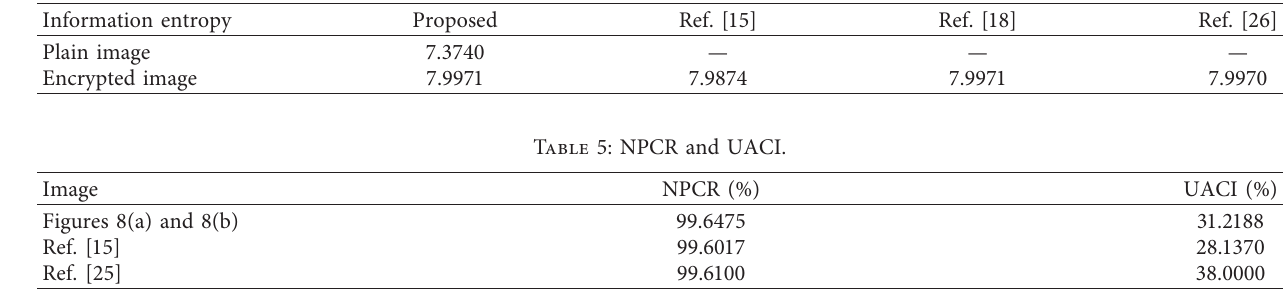
Table 4: Information entropy.